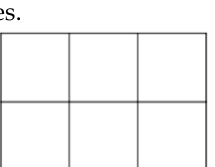
Figure 2. Assignment of the Task 1.